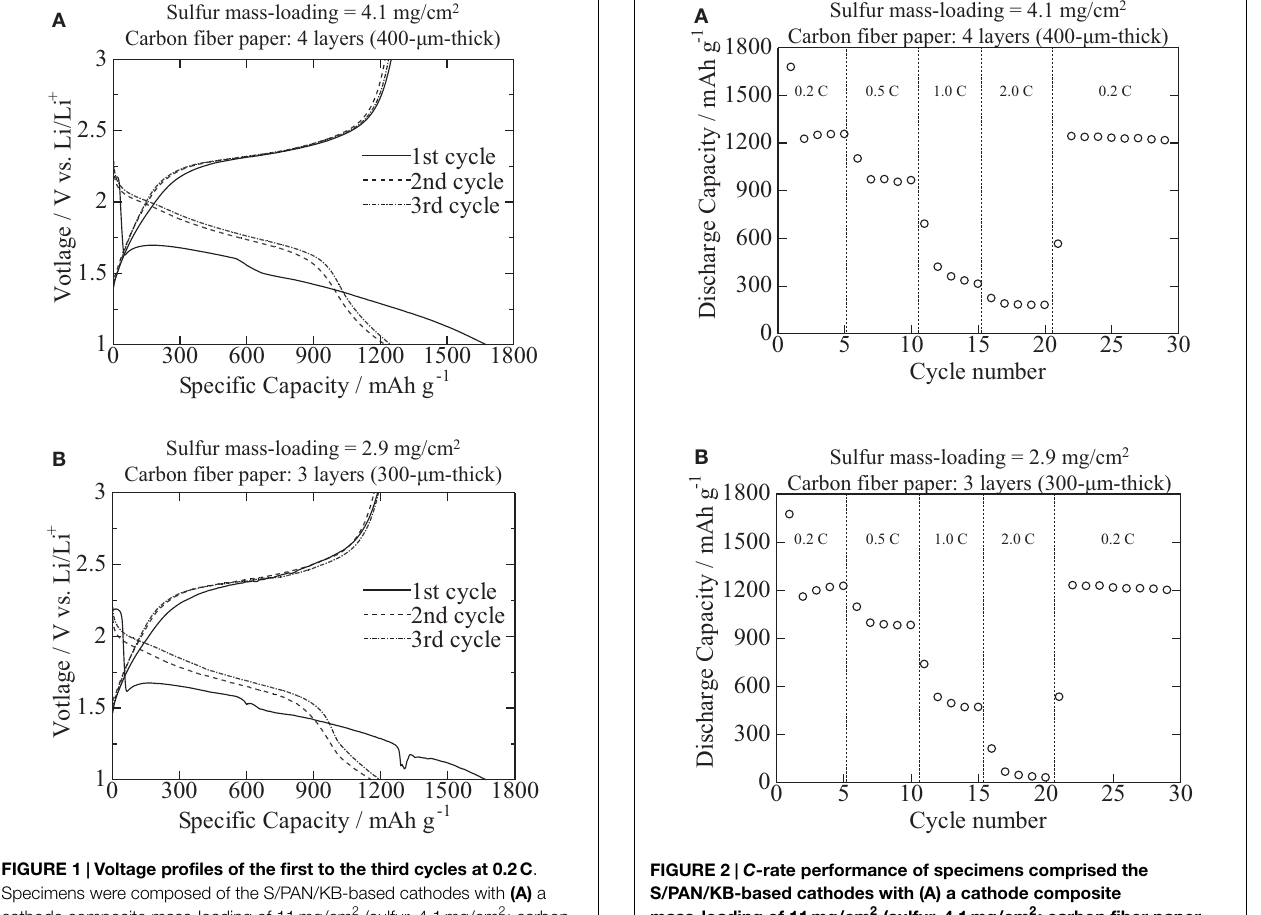
FIGURE 2 | C -rate performance of specimens comprised the S/PAN/KB-based cathodes with (A) a cathode composite mass-loading of 11mg/cm 2 (sulfur, 4.1mg/cm 2 ; carbon fiber paper, 400 µ m thick) and (B) a cathode composite mass-loading of 7.7mg/cm 2 (sulfur, 2.9mg/cm 2 ; carbon fiber paper, 300 µ m thick) that were cast into carbon fiber papers, and lithium foils as anodes